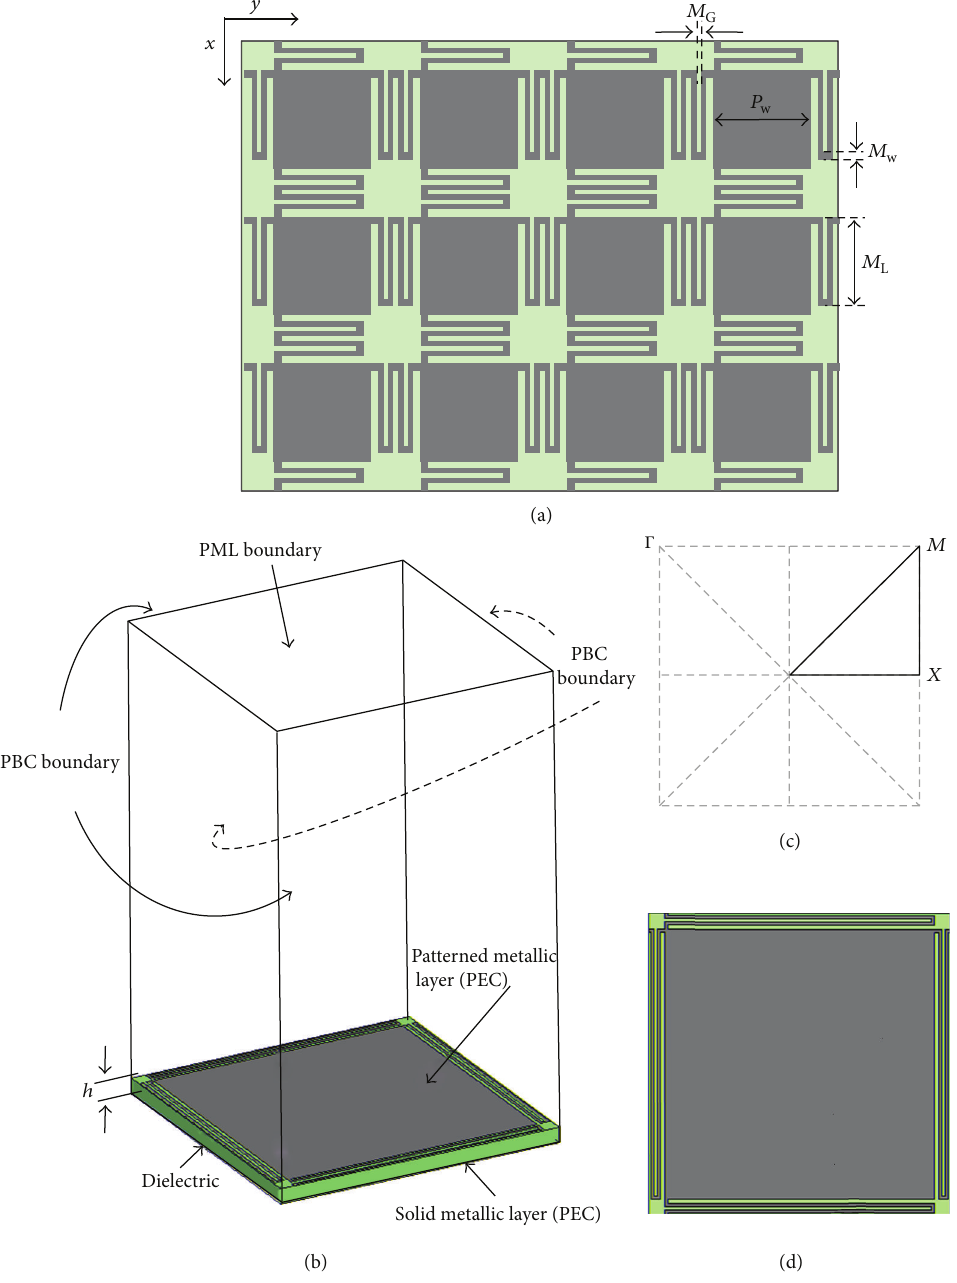
Figure 1: (a) Top view of 2D periodic planar EBG structures made of patch and two-turn meander lines. (b) Computational setup used to extract the dispersion diagram of the EBG-unit cell in infinite array. The appropriate boundaries are shown in the setup. (c) Irreducible Brillouin zone triangle. (d) Top view of the unit